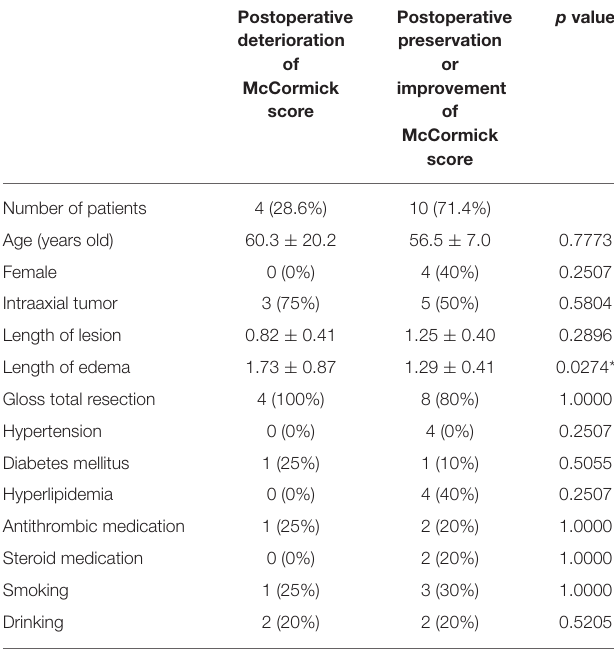
TABLE 2 | Univariate analysis of factors associated with the deterioration of McCormick score at the final